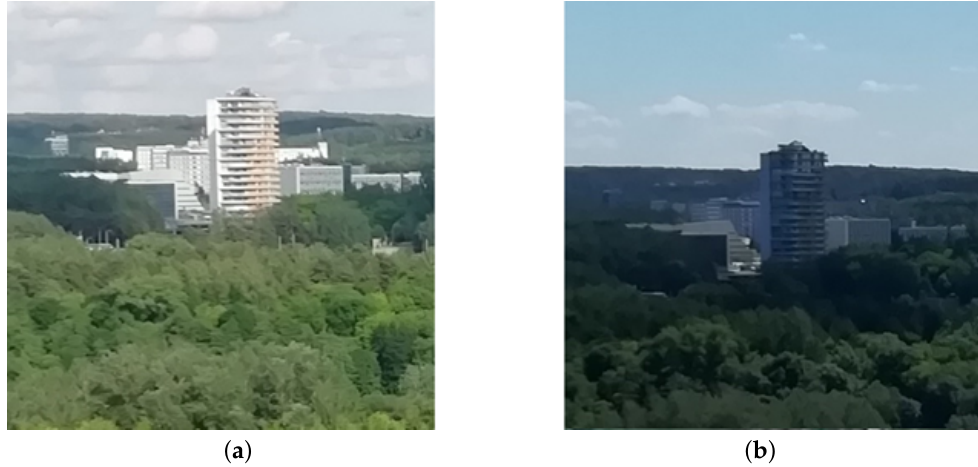
Figure 3. Example of building view ( a ) in the sunshine; ( b ) covered by clouds and